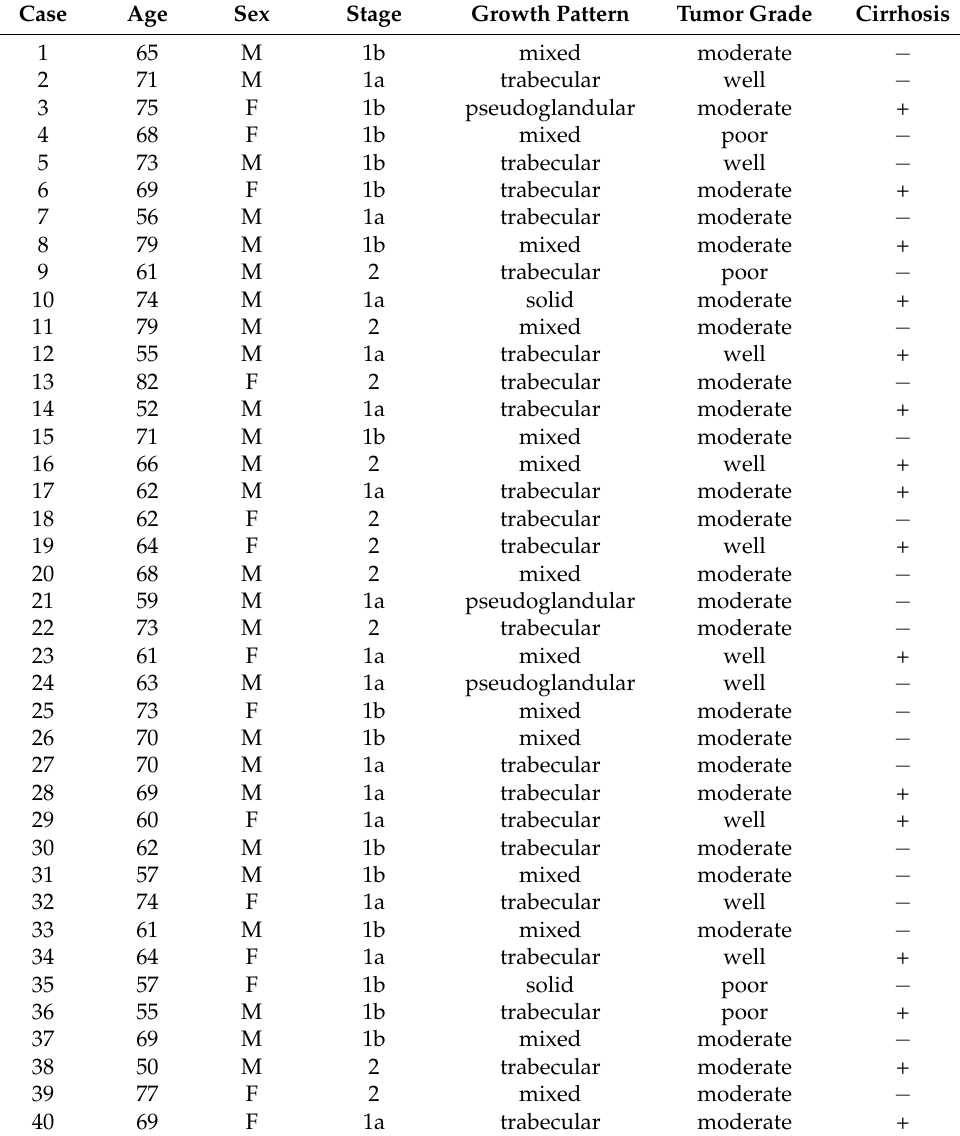
Table 1. Cases for the enrolled HCC patients